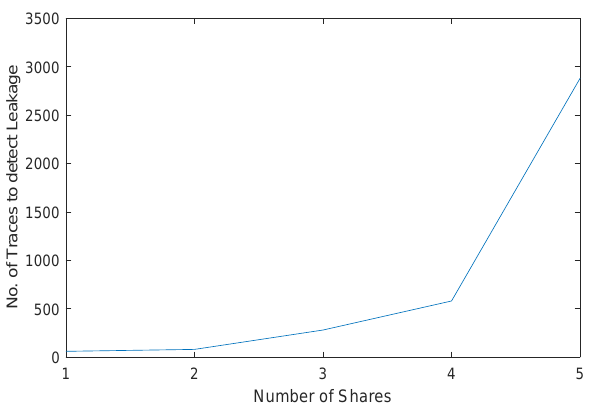
Figure 9: Number of traces to detect leakage for different masking